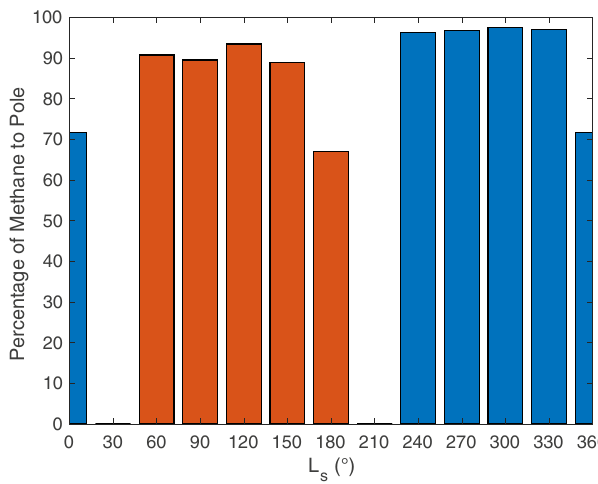
Fig. 3 The fate of methane particles after migration as a function of solar longitude (L s ). The percentage of methane particles that migrate to each pole over the course of one Charon year and become cold-trapped. During some times of the year at each pole (i.e., L s 210 – 30° for Charon ’ s south pole and L s 30 – 210° for Charon ’ s north pole), sublimation rates are high and methane ice is